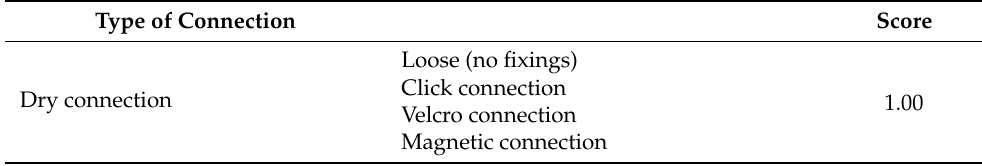
Table 2. Assessment criteria and scores of the Connection Index (CI)